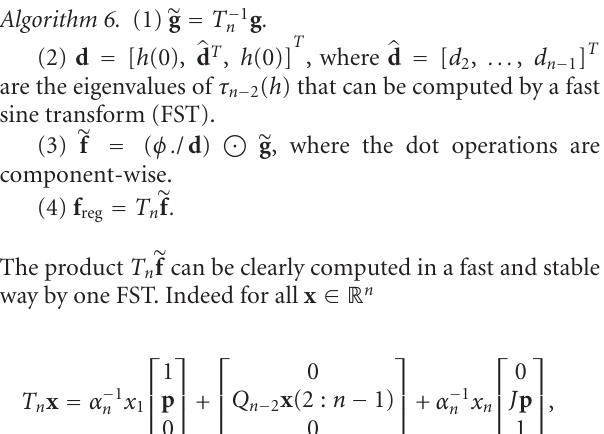
Algorithm 6. (1) (cid:2) g = T − 1